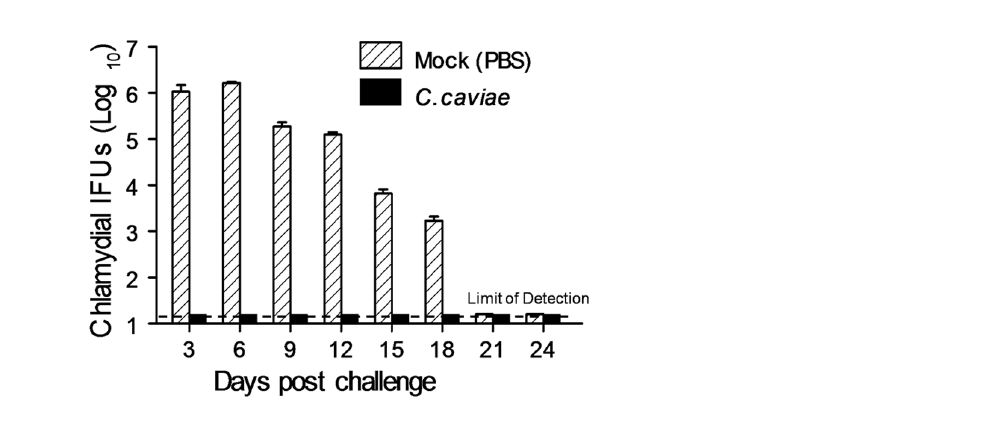
Fig. 1. Vaccination of Guinea pigs with C. caviae Protects Against Genital Chlamydial Infection. Groups (5 per group) of guinea pigs were immunized i.n. with 1 6 10 5 IFU C. caviae or treated with PBS as mock vaccination controls. All animals were rested for 30 days and challenged i.vag. with 1 6 10 5 IFU C. caviae . Chlamydial shedding was monitored every third day after challenge for a month, and are presented as mean ¡ SD for each group at each time